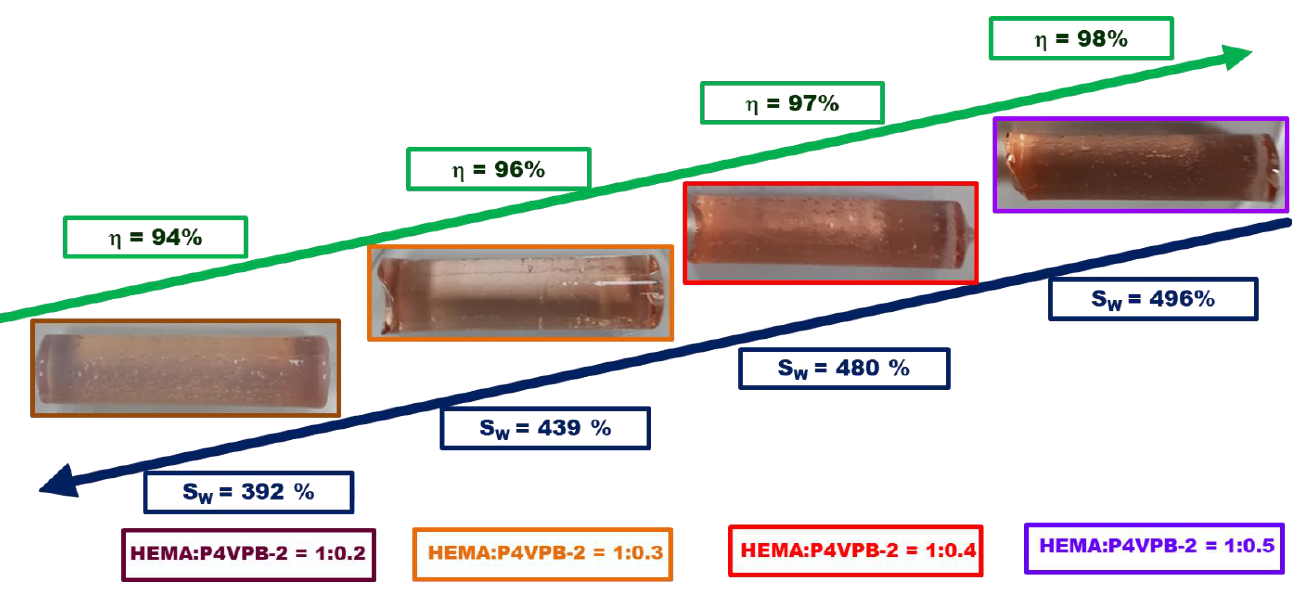
Figure 5. Optical images of HEMA/P4VPB-2 semi-IPNs prepared with various gravimetric ratios between HEMA and P4VPB-2.